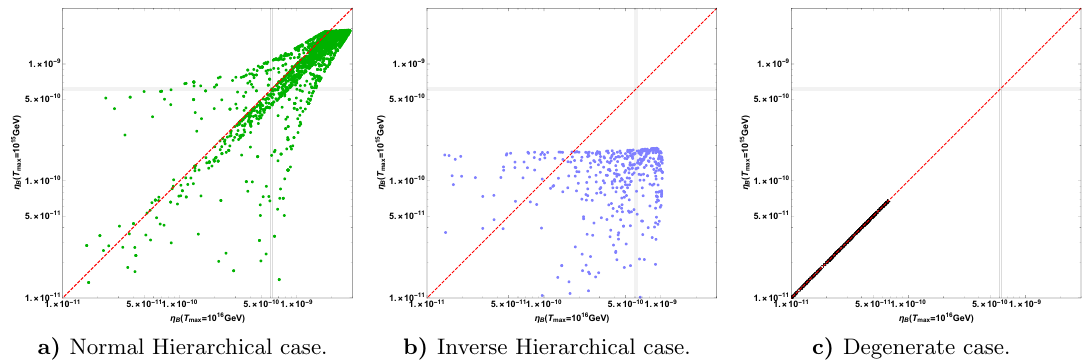
Figure 6 . Correlation plots of (cid:17) B with di(cid:11)erent T max . In the axis of the abscissas (cid:17) B with T max = 10 16 GeV, while in the one of the ordinates (cid:17) B with T max = 10 15 GeV. On the left the normal hierarchical case, in the center the inverse hierarchical one, and on the right the degenerate spectrum case. The red dashed line represents the diagonal to easier drive the eye on the values when the two computed (cid:17) B have the same value. The black continuous lines delimit the 3 (cid:27) value for the experimental determination of (cid:17) B . The two parameters c 1 and c 2 have been (cid:12)xed at 0 : 01, while two values for m light have been considered, m light = 0 : 006 eV for the (cid:12)rst two plots and m light = 0 : 2 eV for the one on the right. Each point in the plots corresponds to a given random choice of the rest of parameters.